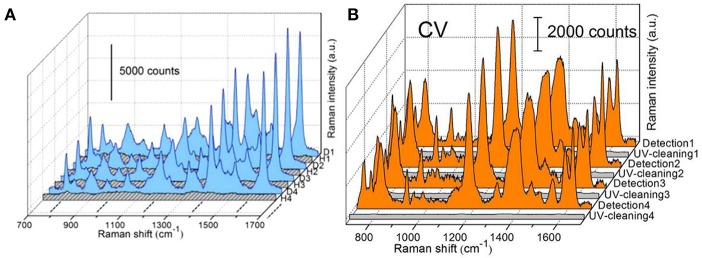
(A) SERS spectra of methylene blue (MB) on AgNRs-HfO2 during the repeated “detection (D)—heating (H)” process. Reproduced with permission from Ma et al. (2016b). Copyright (2016) ACS publications. (B) SERS spectra of crystal violet (CV) adsorbed on AgNRs-TiO2 during the repeated “detection-UV cleaning” process. Reproduced with permission from Ma et al. (2015a).